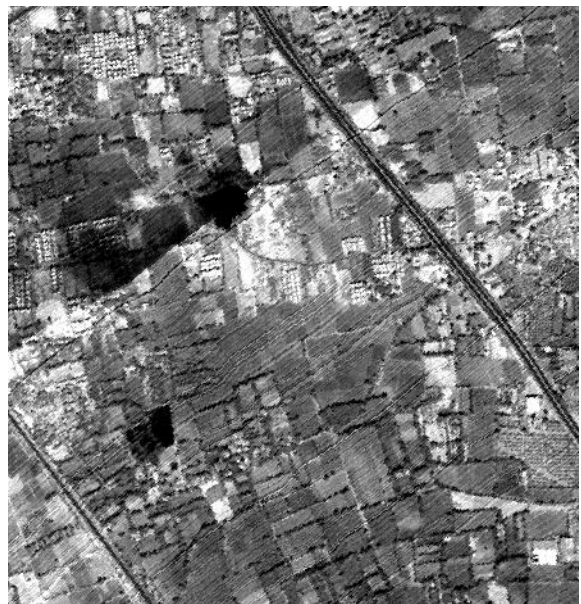
Figure 9. Band 190 (SWIR) of original image with striping